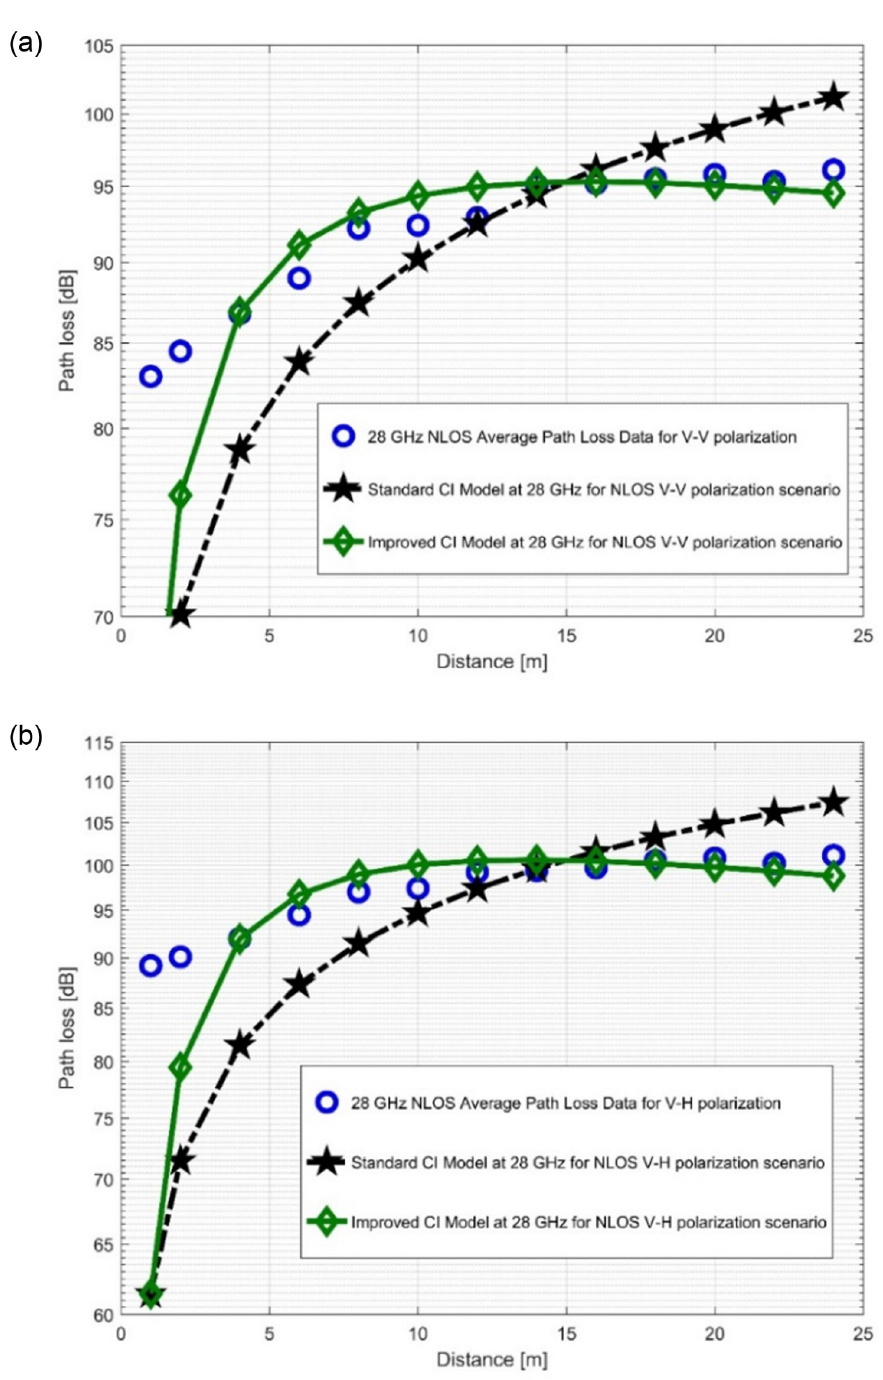
Fig 10. PL vs distance at 28 GHz for the NLOS scenario at (a) V-V polarization, (b) V-H polarization. highest accuracy for the PL prediction at 38 GHz (V-V). With the improved FI PLM, the floating intercept values have been improved significantly. Fig 14a and 14b, as well as Fig 15a and 15b depict the curves of the recorded FI values and the enhanced FI PLM’s values in the NLOS scenario. In the NLOS situation, the effect of changes in antenna polarizations and FBs